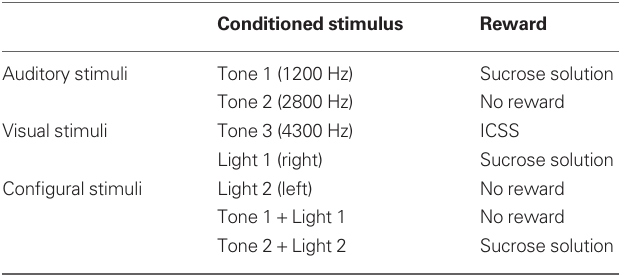
Table 1 | Summary of various conditioned sensory stimuli associated with or without